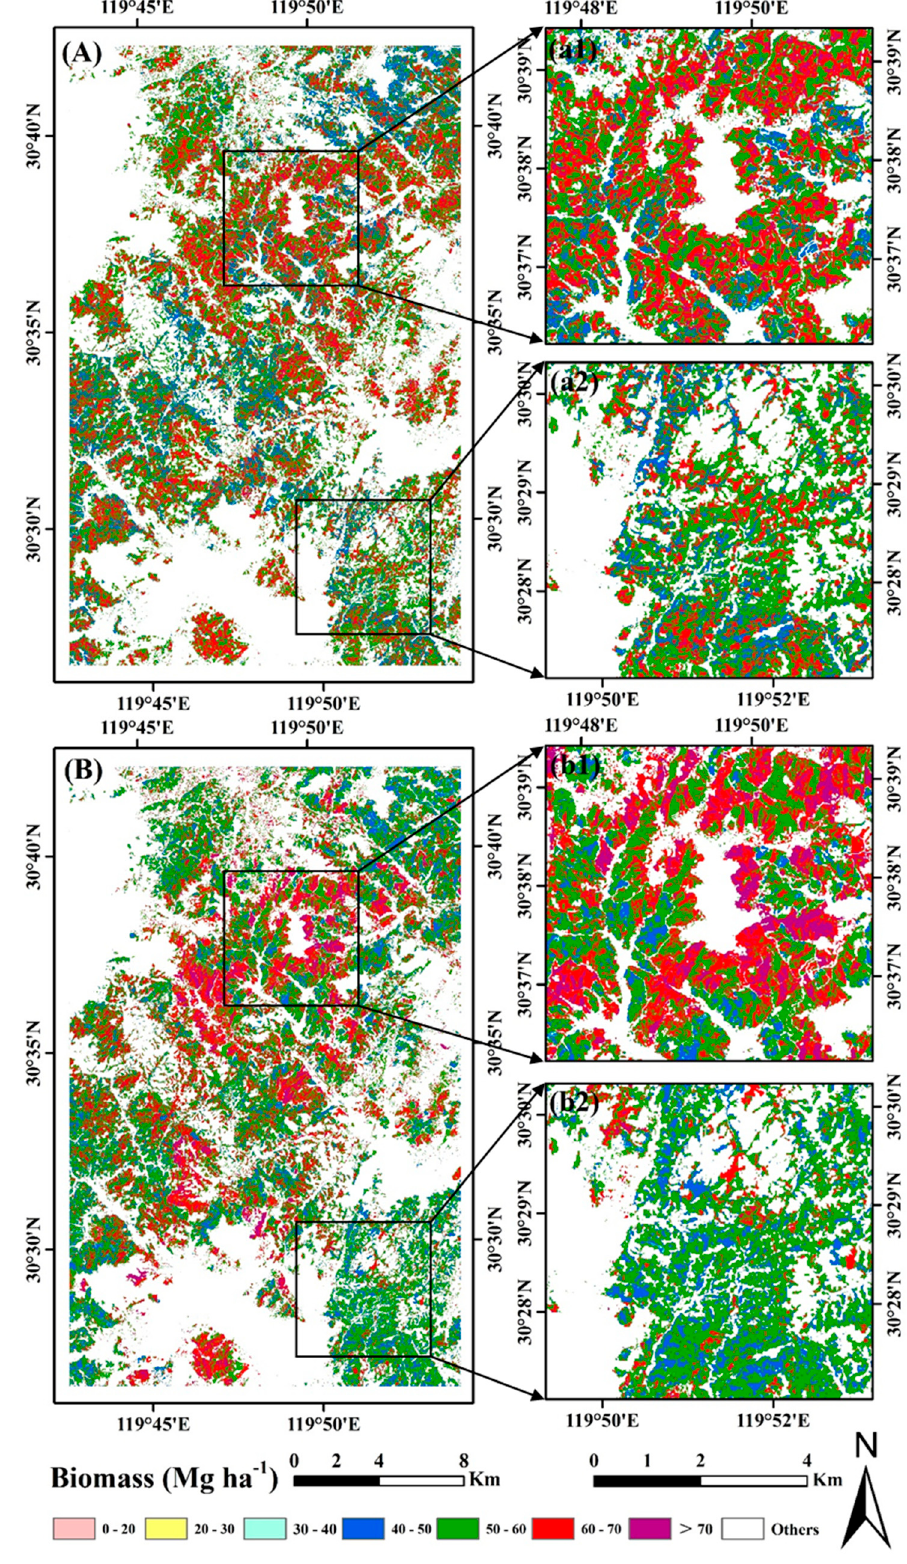
Figure 9. Biomass estimation results with non-stratification using the April image ( A ) with highlighted sites a1 and a2; and stratification of on-year and off-year bamboo forests using the July image ( B ) with highlighted sites b1 and b2.